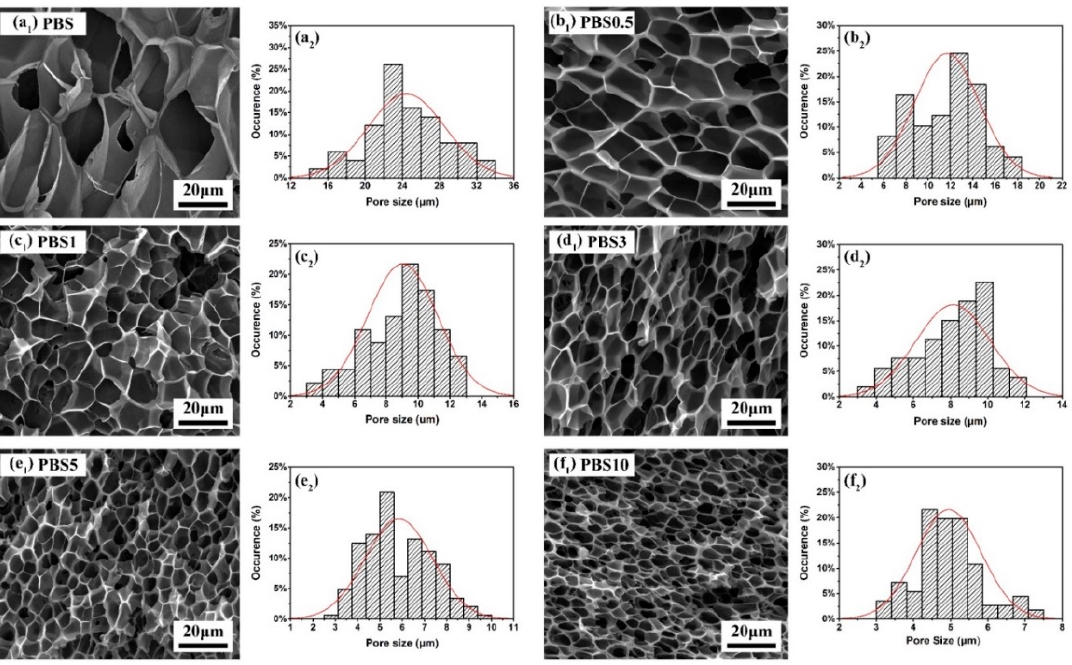
Figure 7. SEM pictures of unfoamed and foamed PBS and PBS5 nanocomposites foams at different intermediate pressure conditions.